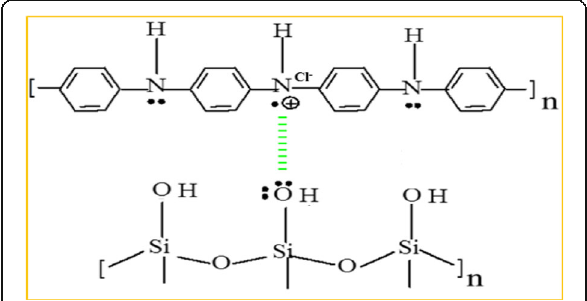
Fig. 7 Schematic presentation of interaction between Pani and